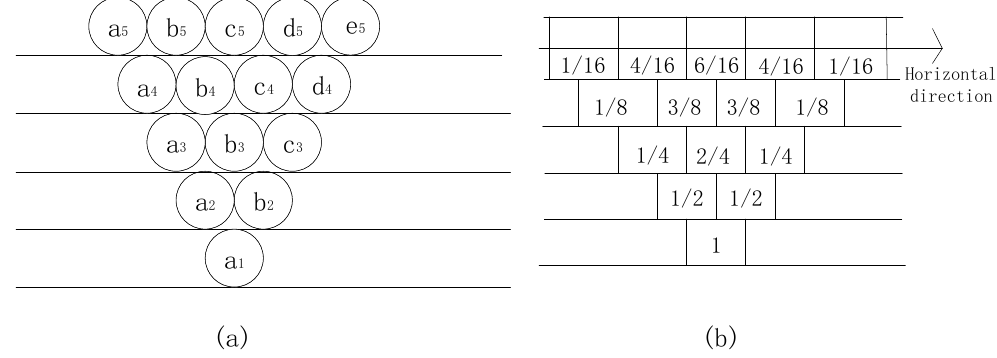
Figure 1. Theoretical model of particulate medium. ( a ) Theoretical model. ( b ) Distribution of particulate movement probability.